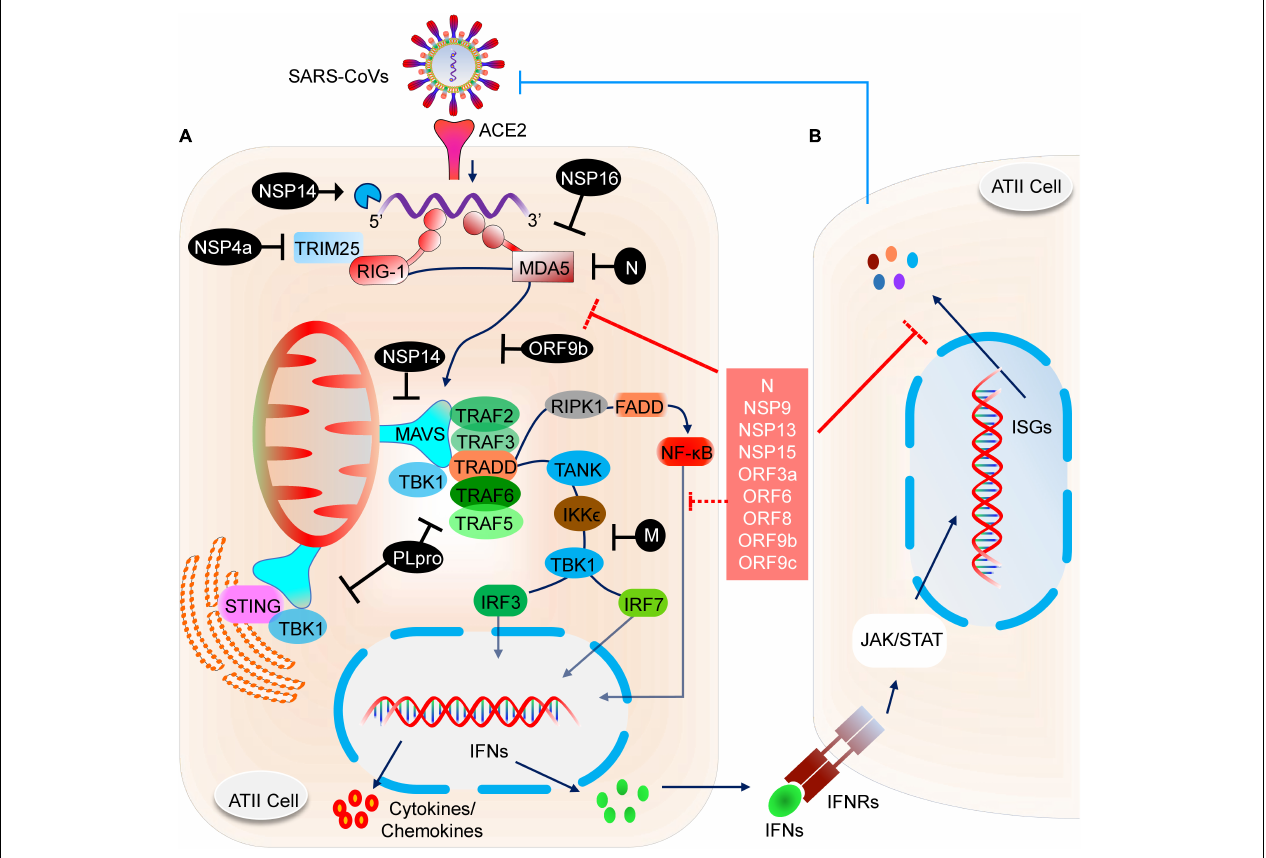
FIGURE 2 | Molecular and signaling pathway implicated in host cell antiviral response. (A) After the viral contents are released into the cytoplasm, the viral RNA is recognized by host cell NASs like RIG-I and MDA5. Counter-defense may be provided by the viral proteins, NSP14 and NSP16 to shield the viral RNA from sensing by the NASs. However, if successfully recognized, RIG-I and MDA5 get activated and subsequently activate the centrally placed MAVS located on mitochondria. MAVS acts as a molecular adaptor that further recruits TRAF2/3/5/6. Association of the type of TRAF with MAVS is suggested to determine the type of downstream signaling, i.e., IRF3/7 and/or NF- κ B. At the MAVS junction, the association of TRAF5/6 with TRADD, FADD, and RIPK1 activates NF- κ B. Whereas, binding of MAVS with STING activates TBK1 and IKK ε by interacting with TRAF2/3, which eventually results in the activation of IRF3 and IRF7 (Chen et al., 2014). Activated IRF3, IRF7, and NF- κ B translocate to the nucleus and induce the expression of IFN genes. (B) The transcribed IFNs act on the respective IFN receptors (IFNRs) present on the host cells as well as on other innate immune cells, thus signaling in a both autocrine and paracrine manner. Signaling via IFNRs activates the JAK/STAT signaling pathway and subsequently induces the expression of ISGs. These molecular events were recently reviewed (Rehwinkel and Gack, 2020). ISGs transcribed will eventually inhibit viral propagation. However, SARS-CoV and likely SARS-CoV-2 have developed counter-defense mechanisms to interfere at various steps in the NAS signaling pathway. NSP4a inhibits TRIM25, which is required for RIG-I activation. N protein inhibits MDA5, NSP14 inhibits MAVS, ORF9b inhibits RIG-I/MDA5 activation complex, M protein interferes with TANK, IKK ε , and TBK1 signaling, and PLpro inhibits various RIG-I, MDA5, and MAVs downstream signaling steps. SARS-CoV-2 proteins acting at various steps in blocking NAS and IFN signaling are shown in the red box. NAS, Nucleic acid sensors; RIG-I, Retinoic acid-inducible gene I; MDA5, melanoma differentiation-associated protein 5; TRAF, TNF receptor-associated factor; STING, ER-associated stimulator of interferon genes; FADD, FAS-associated death domain protein; IRF, Interferon regulatory factor (IRF3/7); TRADD, TNFR1-associated death domain protein; IKK ε , I κ B kinase- ε ; RIPK1, Receptor-interacting protein 1; TANK, TRAF family member-associated NF-kappa-B activator; TBK1, TANK-binding kinase 1; ISG, Interferon stimulatory gene; TRIM25, Tripartite motif-containing protein